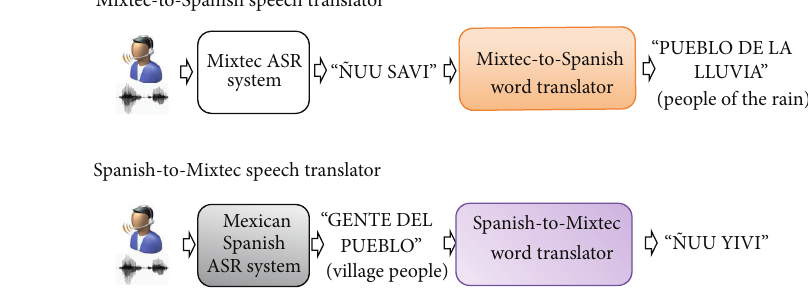
Figure 9: Integration of the baseline Mixtec ASR for other speech applications.